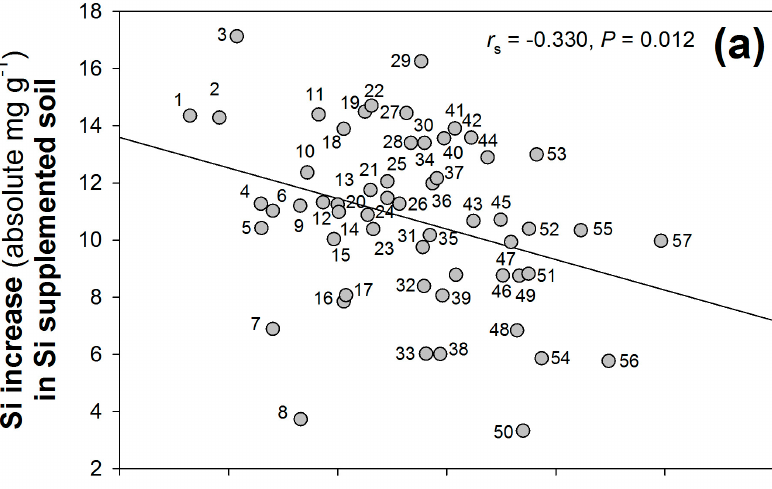
Figure 4. The relationship between shoot Si concentrations when growing in low-Si soil and the ( a ) absolute and ( b ) relative (%) increase in Si accumulation when accessions were grown in high (Si- supplemented) soil. Accessions indicated (1) Gaz2, (2) Adi6, (3) Adi15, (4) Bd23–01, (5) BdTR3a, (6) Mig3, (7) BdTR11a, (8) BdTR9a, (9) Bd3–1 RR 2009, (10) BdTR1k, (11) BdTR1d, (12) BdTR12a, (13) Adi1, (14) BdTR13c, (15) Bd3–1 Bd3–2, (16) BdTR11g, (17) Bd21–3 ANU, (18) Adi18, (19) Bd21, (20) Adi8, (21) BdTR10f, (22) BdTR1j, (23) Bd18–1, (24) Kah6, (25) Koz2, (26) Koz3, (27) Gaz6, (28) Kah4, (29) Kah5, (30) BdTR3s, (31) BdTR10i, (32) Bdis05–07, (33) BdTR2a, (34) BdTR10c, (35) Bd21–3 INRA, (36) Bdis28–08, (37) Adi16, (38) Gal1, (39) Cas2, (40) BdTR9f, (41) BdTR5m, (42) Bdis05–09, (43) BdTR3b, (44) BdTR2j, (45) Gaz3, (46) BdTR2p, (47) Bdis25–04, (48) Bdis22–06, (49) Bd25–01, (50) Bdis31–02, (51) Bd21 RR 2009, (52) Bdis31–01, (53) Bdis22–01, (54) Bdis32–02, (55) Bdis25–10, (56) BdTR1c, and (57) Pal2032. 3. Discussion Accessions of B. distachyon with the greatest capacity for Si accumulation under low- Si conditions tended to originate in regions with lower temperatures and higher precipi- tation patterns. It seems possible that water limitation hinders Si accumulation, which is potentially exacerbated by warmer temperatures. This refutes our hypothesis that